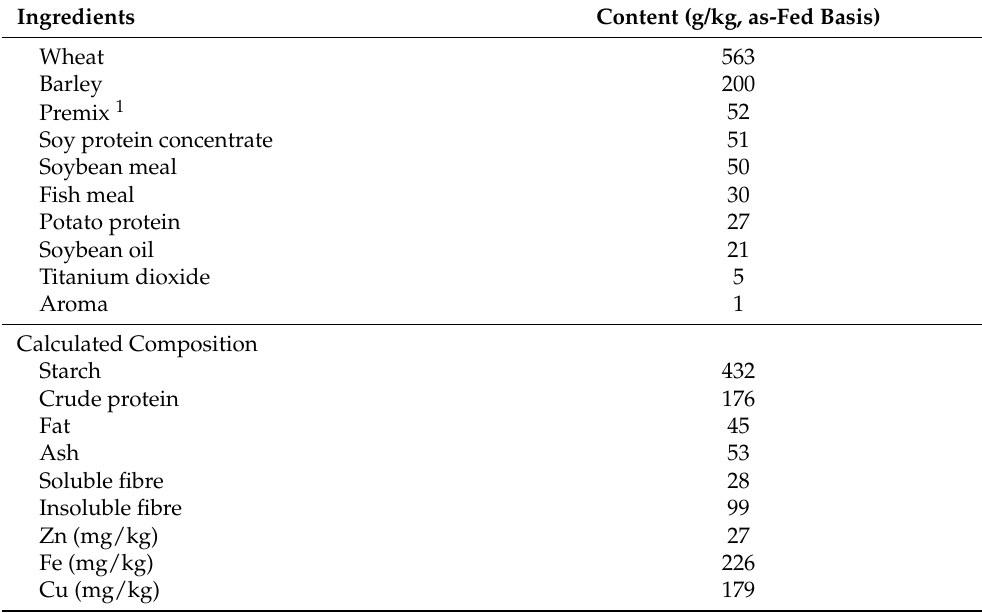
Table 1. Ingredients in the basal diet and calculated content (as-fed) of selected nutrients and micro